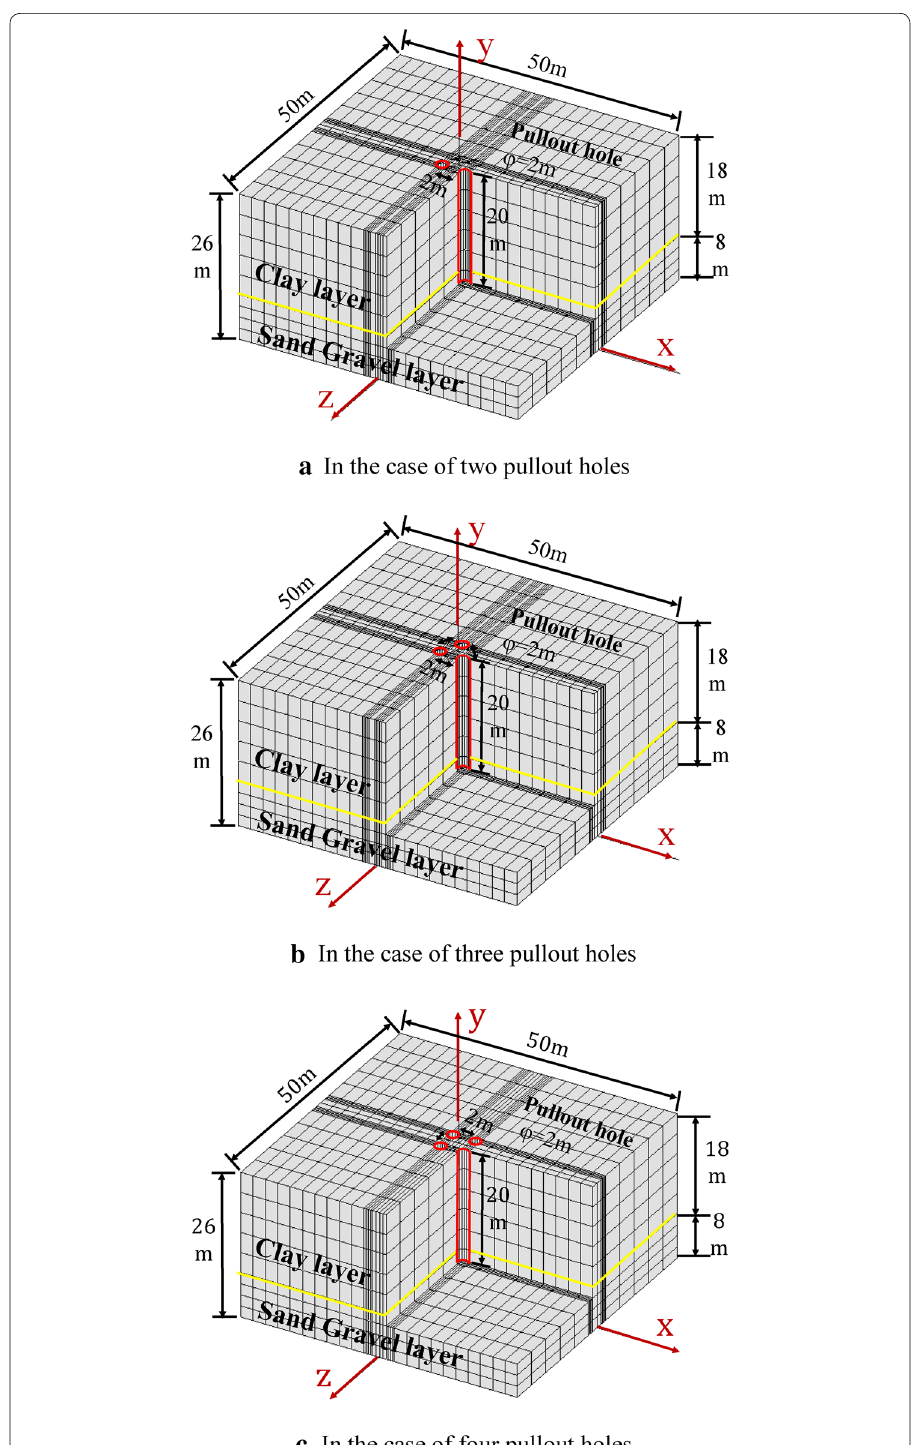
Fig. 2 Analysis section for ground and pullout holes. a In the case of two pullout holes. b In the case of three pullout holes. c In the case of four pullout